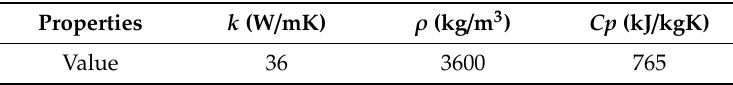
Table 5. Thermophysical properties of the Al 2 O 3 nanoparticles